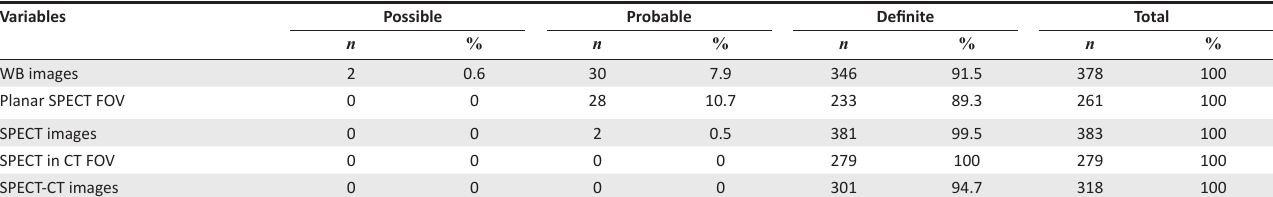
TABLE 2: Lesion detection certainty. Variables